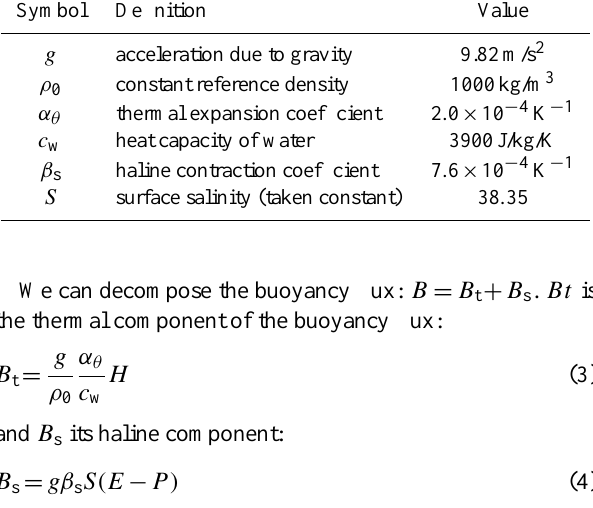
Fig. 7. Depth averaged vertical buoyancy gradients for the top, intermediate and bottom layers from the Dyfamed data set.